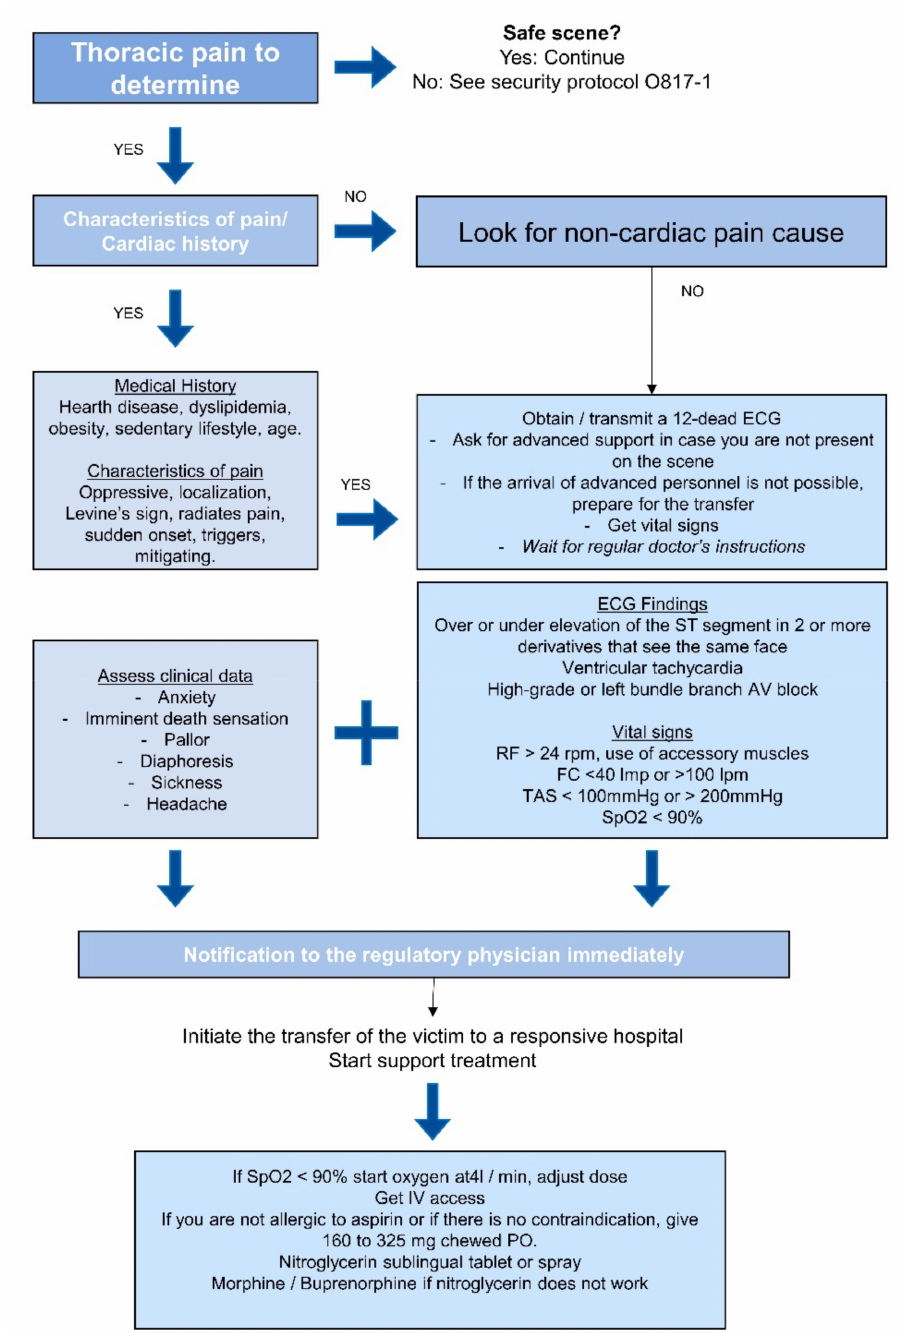
Figure 1. Thoracic pain management